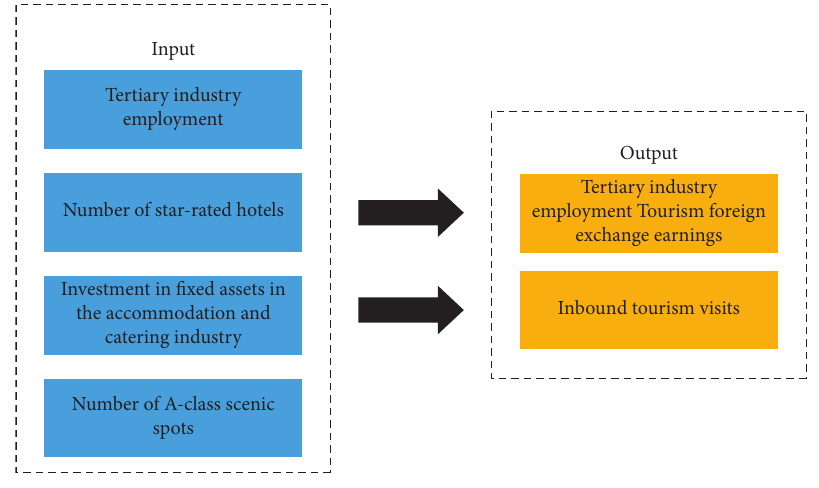
Figure 2: Input-output